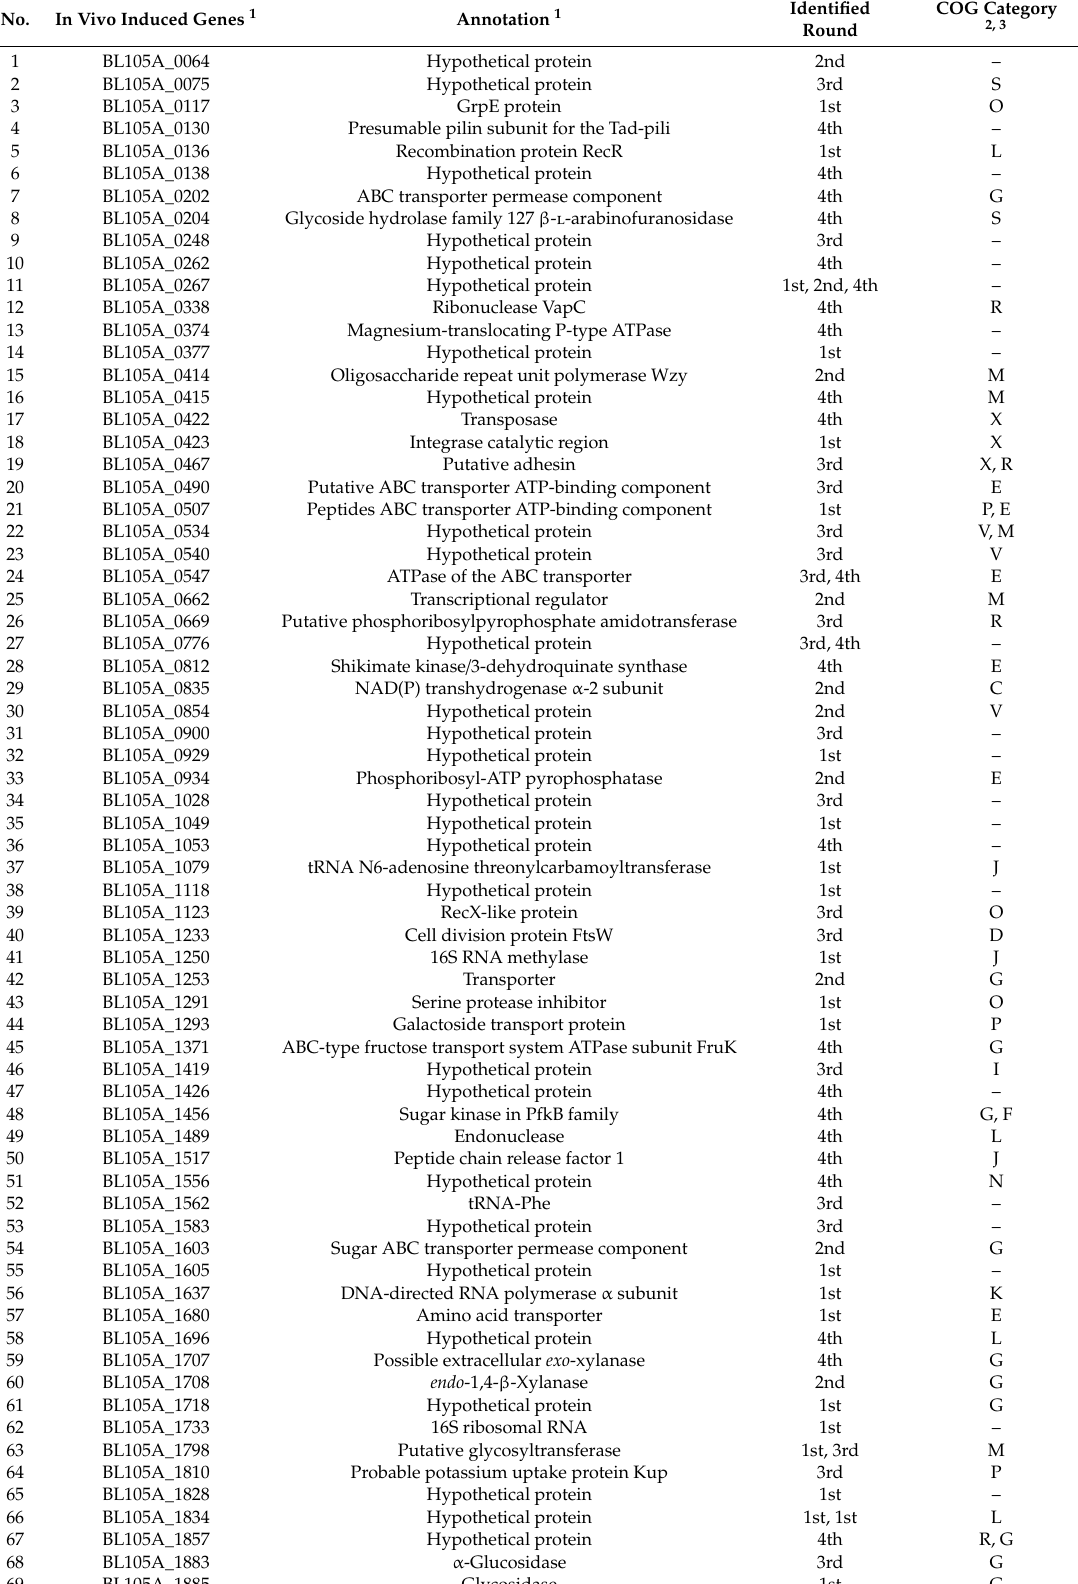
Table 3. In vivo-induced genes identified by R-IVET using B. longum 105-A.